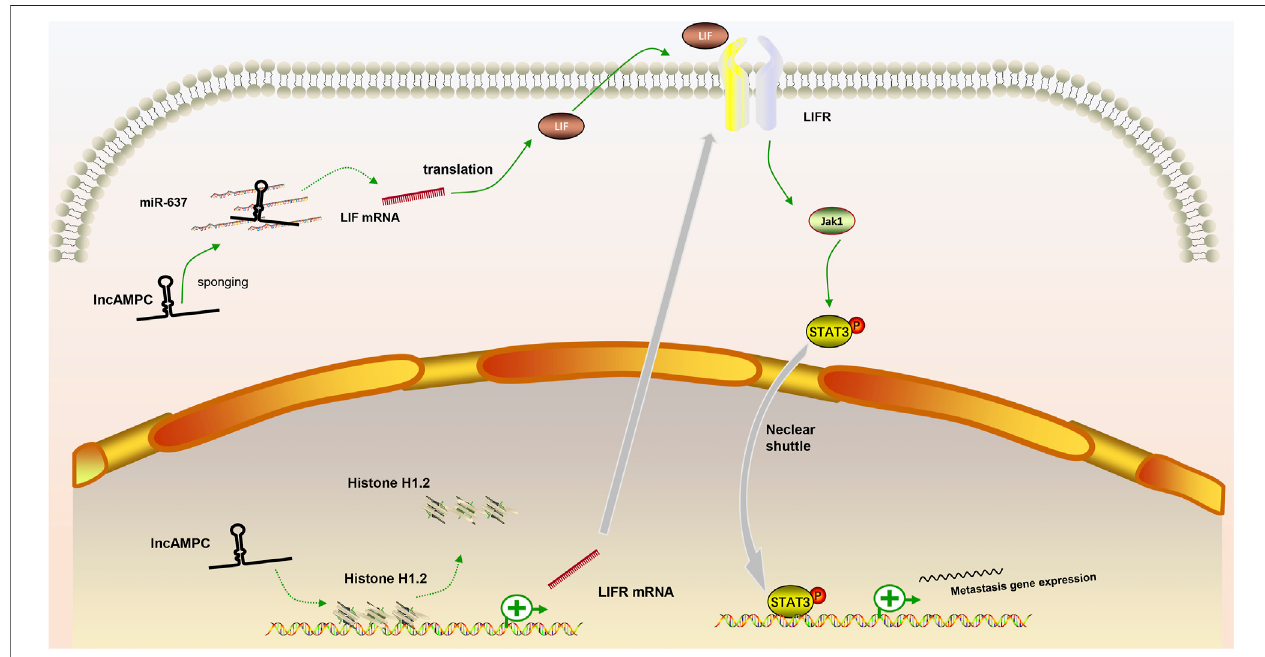
FIGURE3| ThepositivefeedbackloopbetweenlncRNAsandkeysignalingeffectors.(1)Inthecytoplasm,lncAMPCupregulatedLIFexpressionbyspongingmiR- 637;(2)Inthenucleus,lncAMPCenhancedLIFRtranscriptionbydecoyinghistoneH1.2awayfromtheupstreamsequenceoftheLIFRgene;(3)Theincreasedbindingof LIF and LIFR stimulated the JAK1-STAT3 pathway to promote metastasis-associated gene expression.